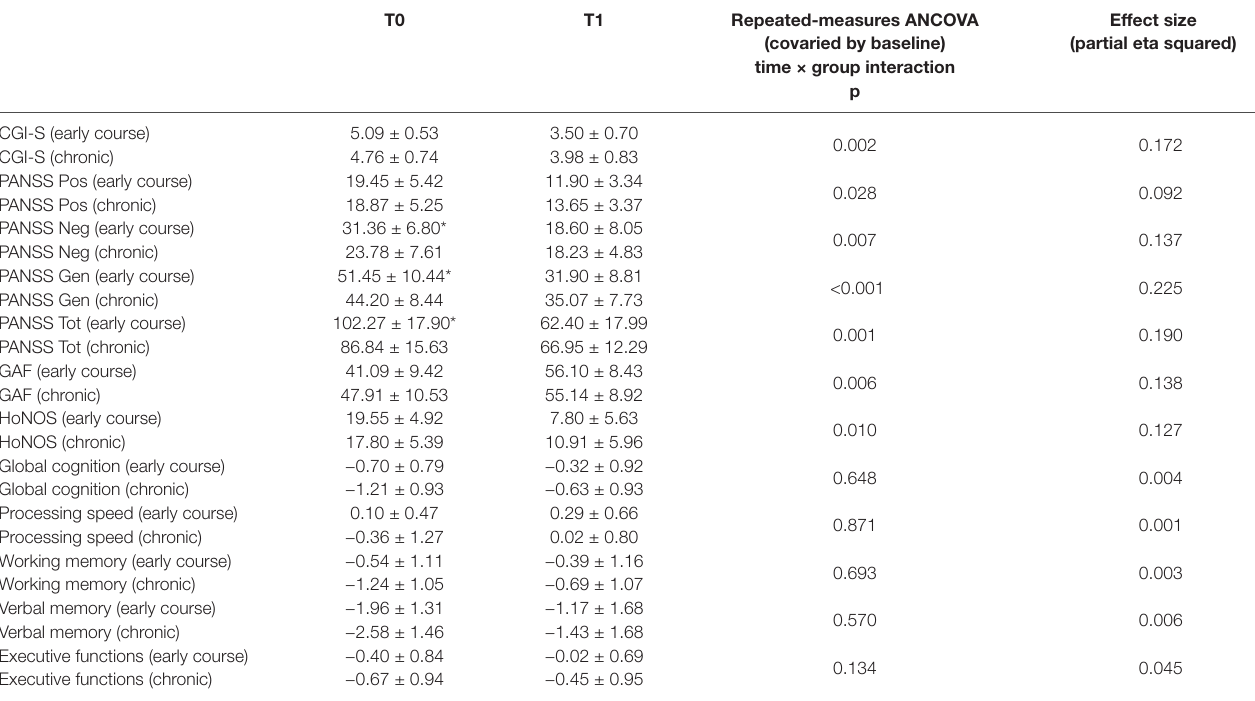
TABLE 2 | Between-group comparisons of change of clinical, neurocognitive, and psychosocial functioning variables.